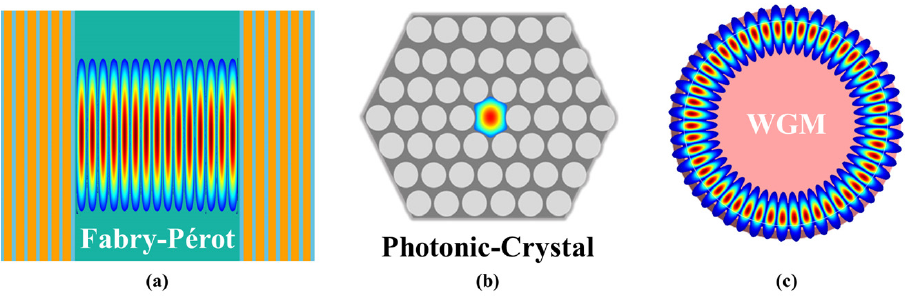
Figure 1. Schematic of the ( a ) Fabry–Pérot, ( b ) photonic crystal, and ( c ) WGM optical microcavities.